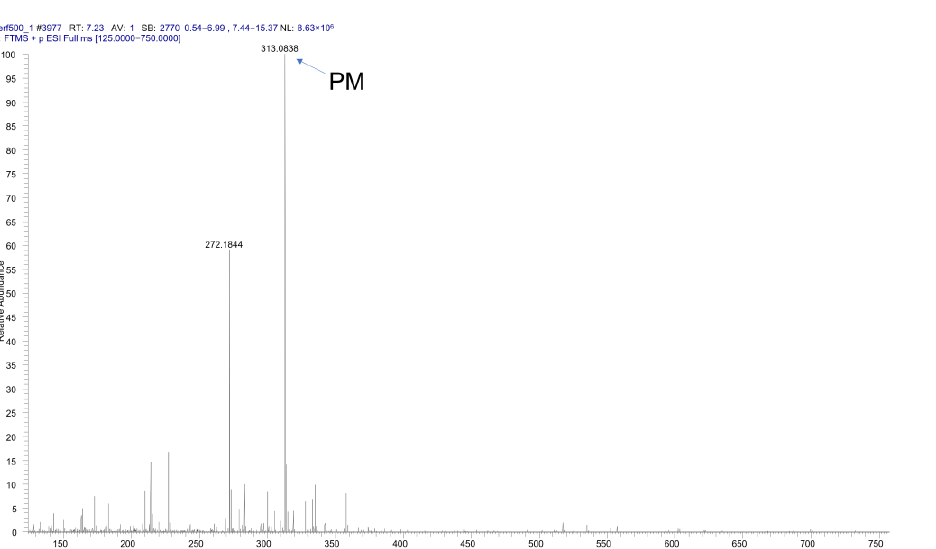
Figure A5. HRMS spectrum of paracetamol cysteine generated in rat small intestine luminal after 90 min of perfusion.